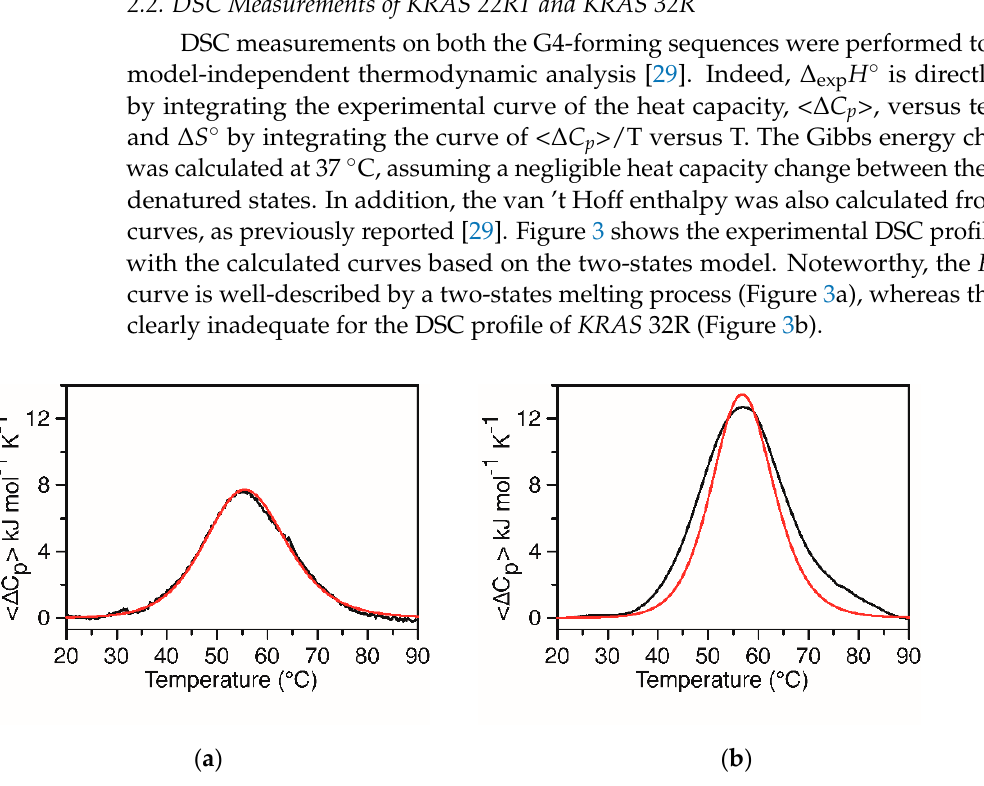
Figure 3. Experimental differential scanning calorimetry (DSC) profiles (black line) and van ’t Hoff calculated curves based on the two-states model (red line) for ( a ) KRAS 22RT and ( b ) KRAS 32R. The buffer solution was 20 mM KH 2 PO 4 /K 2 HPO 4 with 60 mM KCl and 0.1 mM EDTA at pH 7.0.